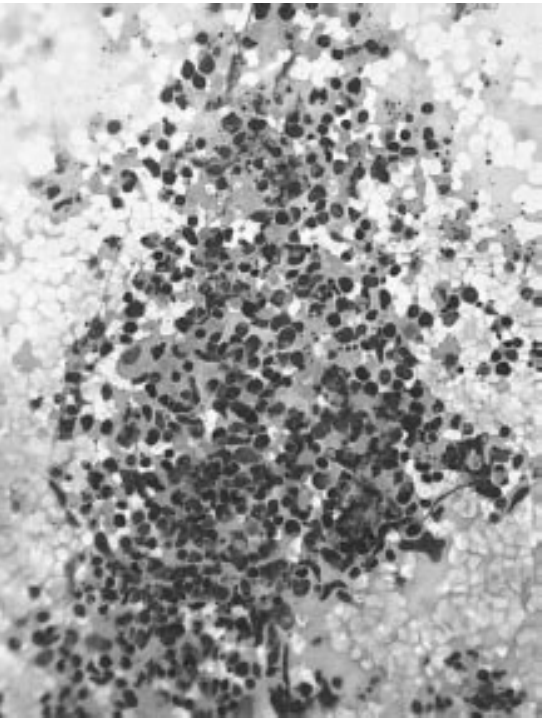
Fig. 4. High resolution image ( (cid:2) 40) used for telecytology diagnosis (small cell lung carcinoma, the same case as shown in Fig.